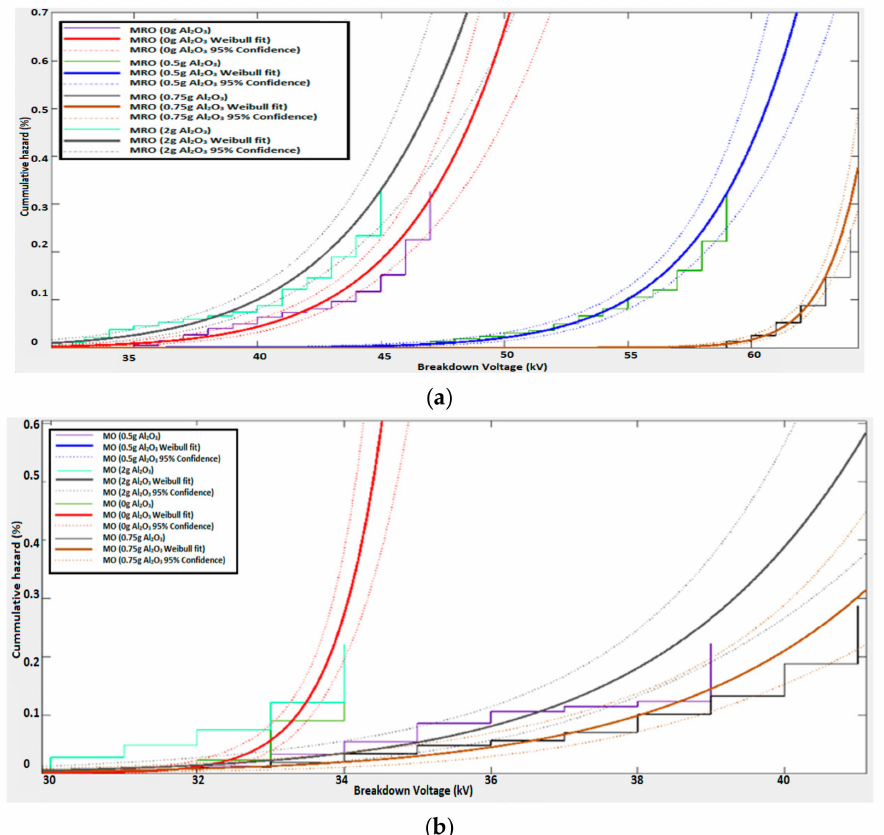
Figure 9. Cumulative breakdown voltage hazard function in different concentration of the Al 2 O 3 with Weibull fit showing the 95% confidence, ( a ) MRO, ( b )